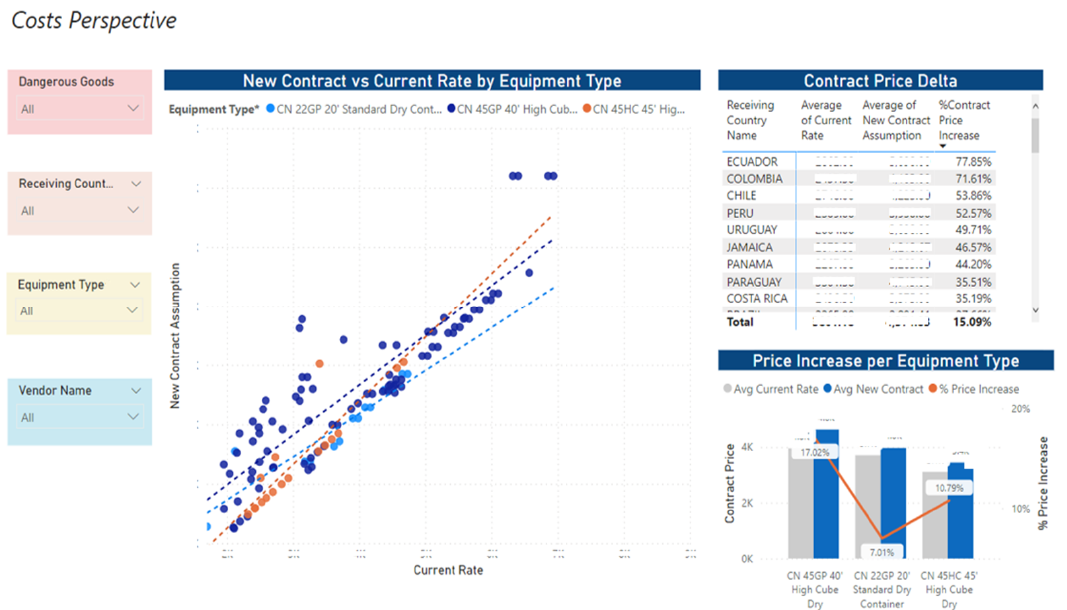
Figure A1. Costs Perspective. The legend corresponds to the notation introduced in Section 4.3.1. The values for current rates, new contract assumptions, and costs are sensitive data and intentionally covered.